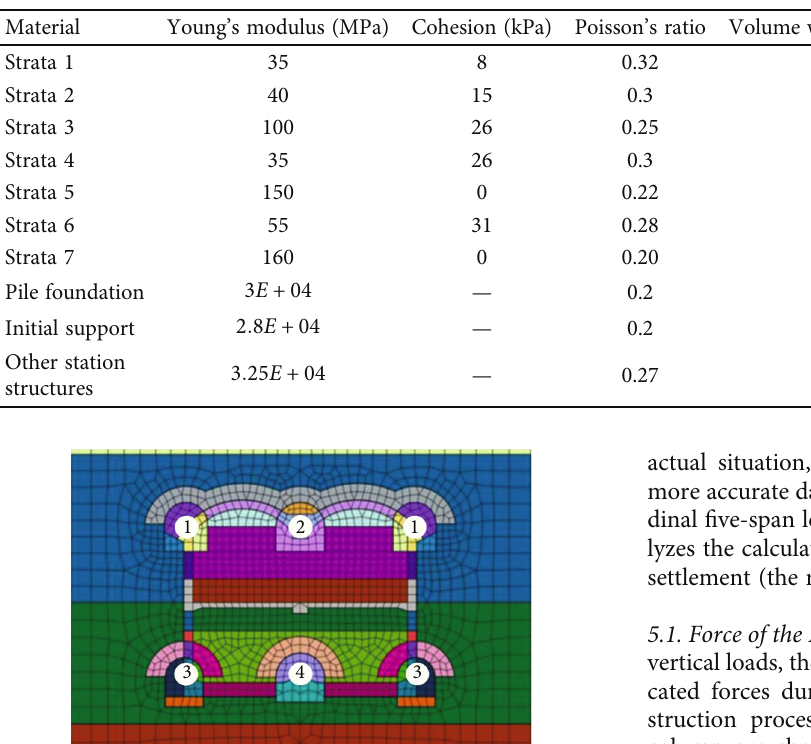
Table 2: Parameters of the soil and station structure.